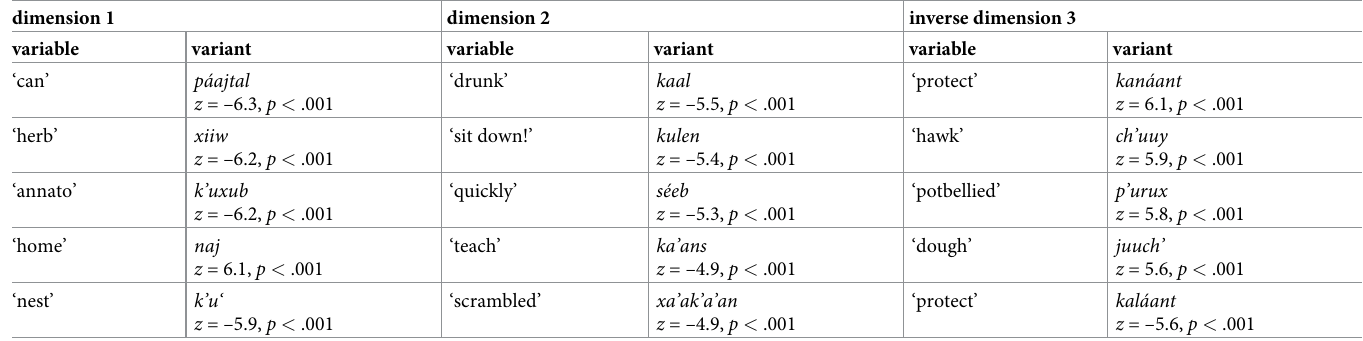
Table 2. We applied a stepwise procedure of forward model selection integrating all relevant Table 1. List of the five variants per dimension which reached the highest absolute z- scores in the corresponding dimension in a logistic regression with the (non-) occurrence of a variant as a dependent variable and the three scores of multidimensional scaling as independent variables in a linear model ( n speakers = 157; n observations =